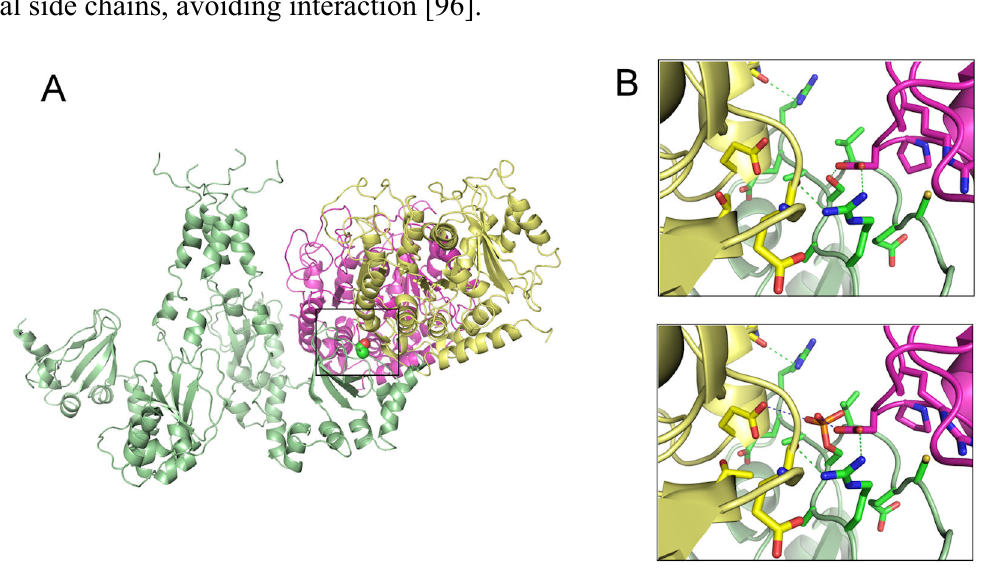
Figure 2. Protein-protein docking interaction of TRPV1 with tubulin. (A) Side view of the interaction of soluble α (yellow) and β (magenta) tubulin dimers with the tetrameric TRPV1 C-terminus (green). The PKC ε phosphorylation site (Ser-800) is indicated by the black box. (B) Enlarged view of the tubulin-TRPV1 interaction at Ser-800 in the non-phosphorylated (upper) and phosphorylated state (lower). The interaction is stabilized among others by side chain and main chain hydrogen bonds (dotted green lines). In contrast, phosphorylation of Ser-800 by PKC ε clashes sterically (dotted blue lines) with several side chains, avoiding interaction